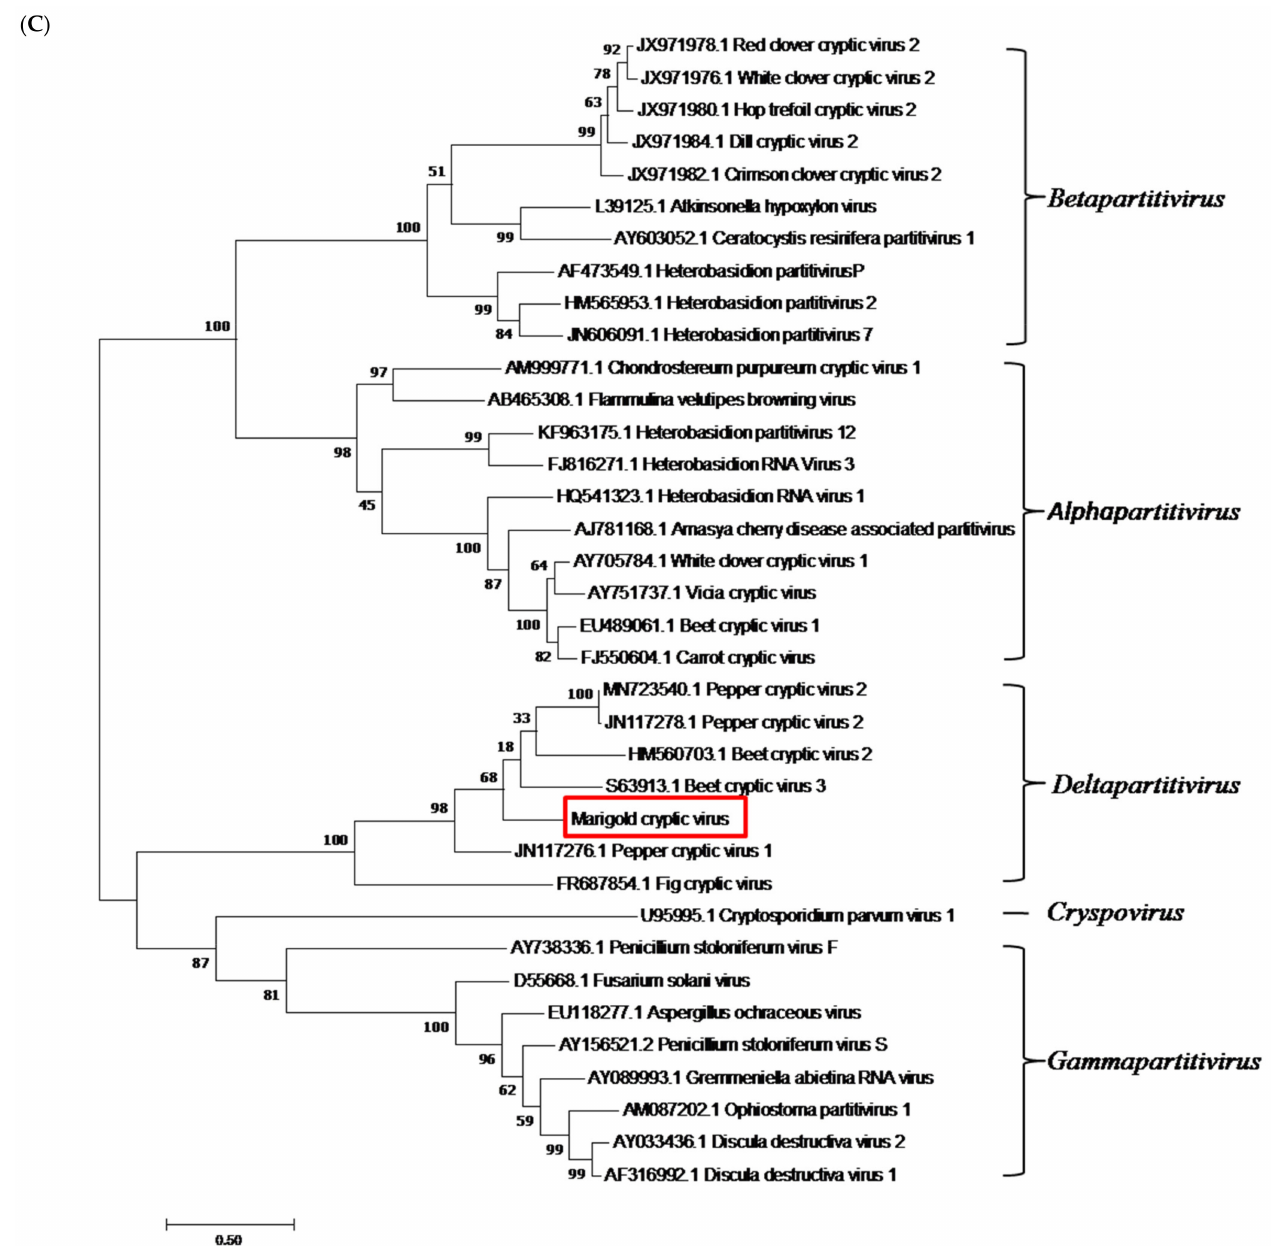
Figure 2. Genome structure of marigold cryptic virus (MCV) and its phylogenetic analyses. ( A ): Diagram showing genome organization of MCV and open reading frames (ORFs) were indicated as boxes on each segment and the ORF positions were also indicated. ( B ): The secondary structure formed by the 5 (cid:48) -untranslated regions (5 (cid:48) UTR) of MCV dsRNA-1 ( a ) and dsRNA-2 ( b ). ( C ): Neighbor-joining tree based on the aa sequence of RdRp of classified members of the family Partitiviridae with 1000 bootstrap replicates. Bootstrap values were given by numbers at the relevant nodes in the